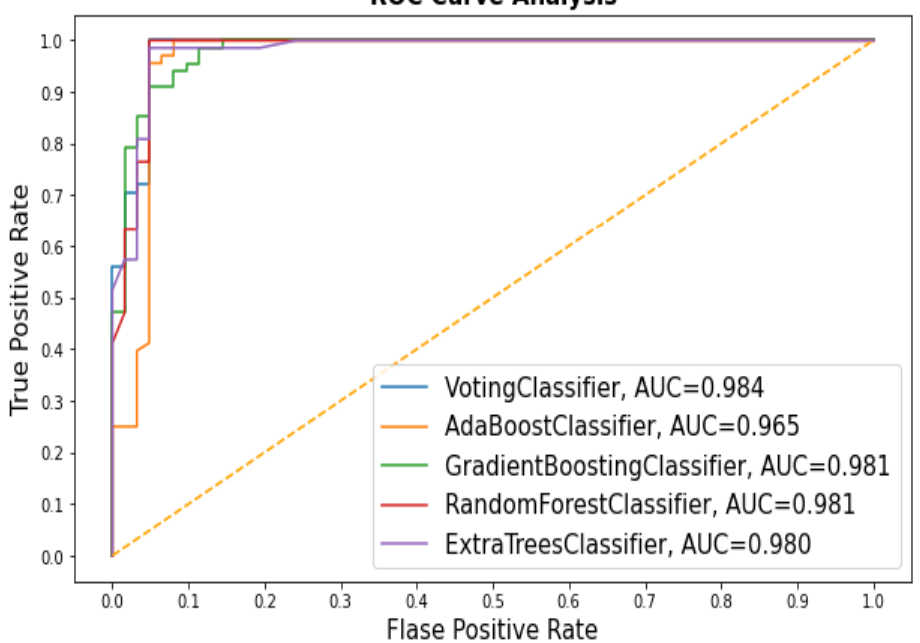
Figure 6. ROC curves of all methods used in the Z-Alizadeh Sani dataset with two classes, CAD and non-CAD. The blue, orange, green, red, and purple colors refer to the developed ensemble voting model with the overall highest score of 98.4%, the AdaBoost model with a 96.5% score, a gradient- boosting model with a 98.1% score, the RF model with an overall highest score of 98.4%, and the extra trees model with a 98% score, respectively.